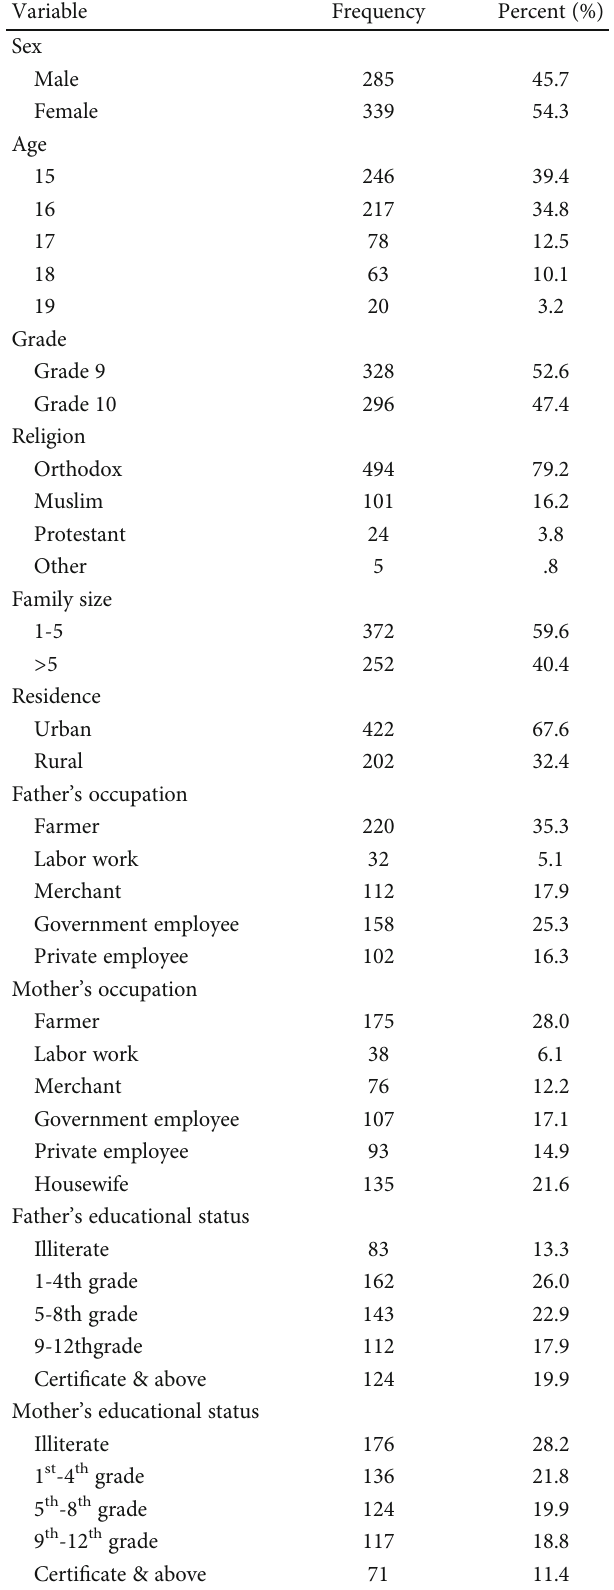
Table 1: Distribution of sociodemographic factors in high school students at Aksum town ( n = 624